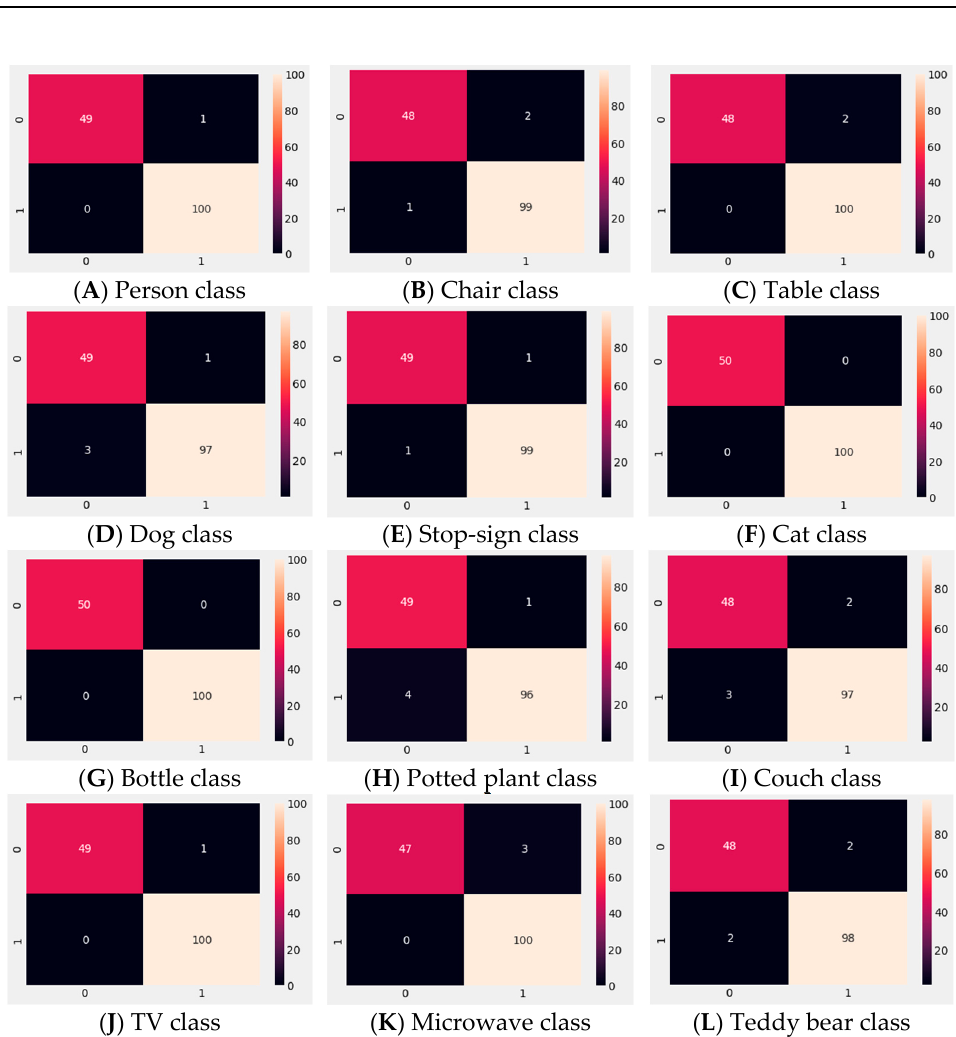
Figure 13. ( A – L ) confusion matrix for known and unknown data detection for each class.